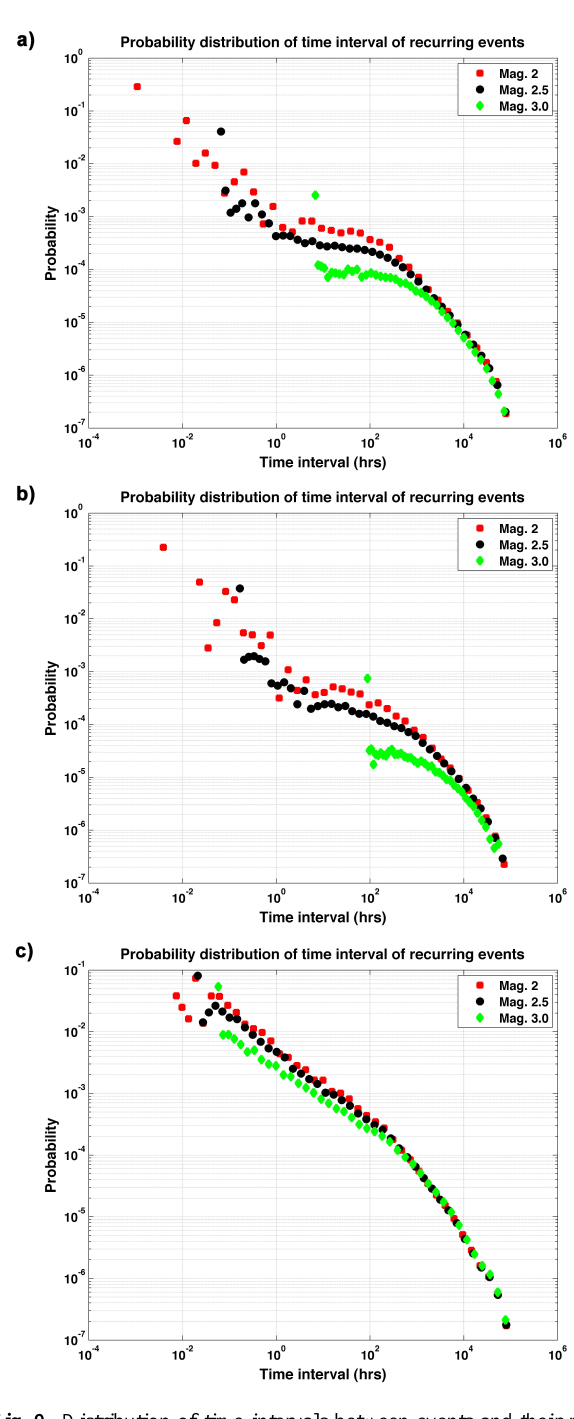
Fig. 9. Distribution of time-intervals between events and their re- currences for different threshold magnitudes obtained for the MC2 catalogs. (a) Region 1; (b) Region 2; (c) Region